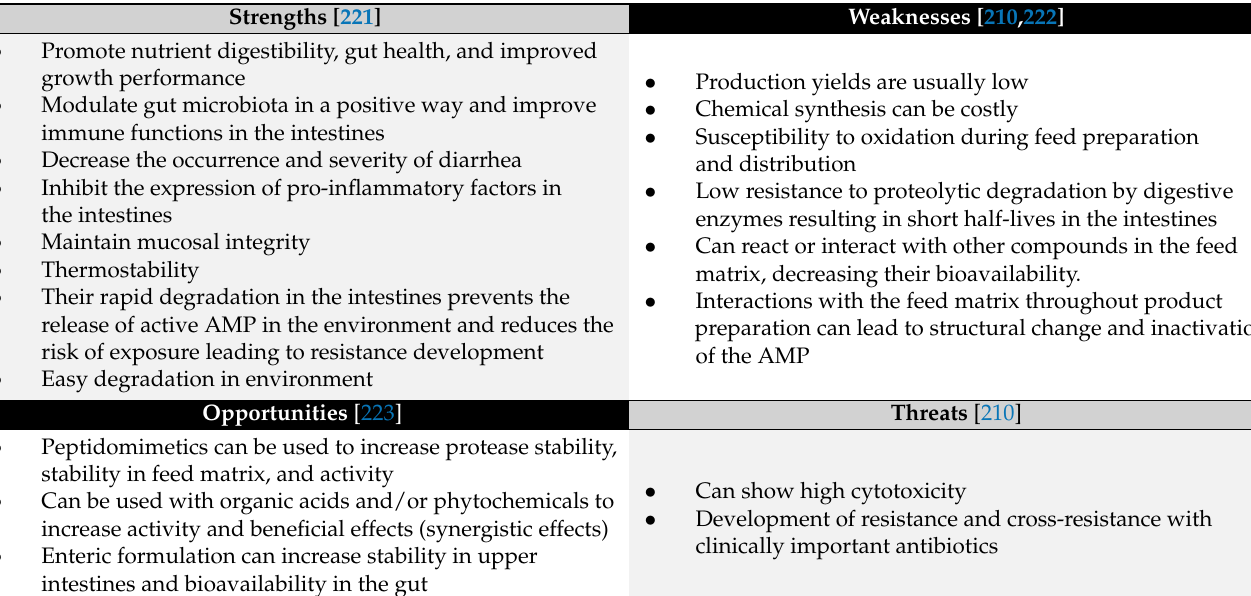
Table 8. SWOT analysis of antimicrobial peptides.